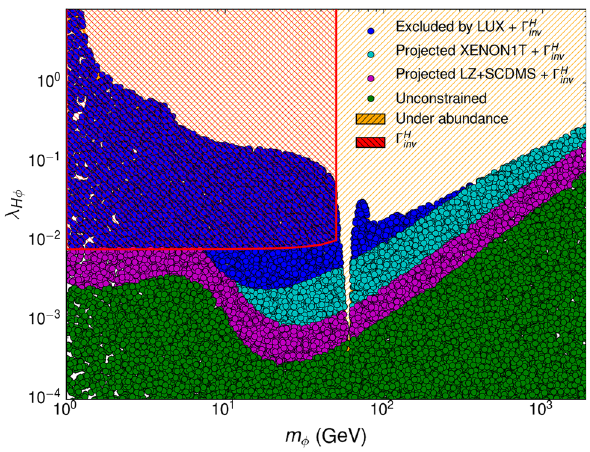
Fig. 3 Constraints on the Higgs portal coupling for scalar